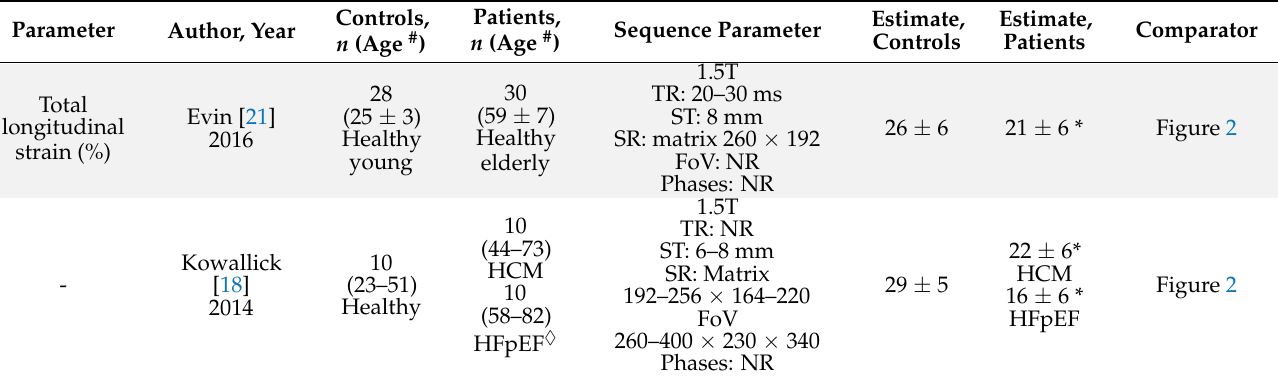
Table 13. LA feature tracking—total longitudinal